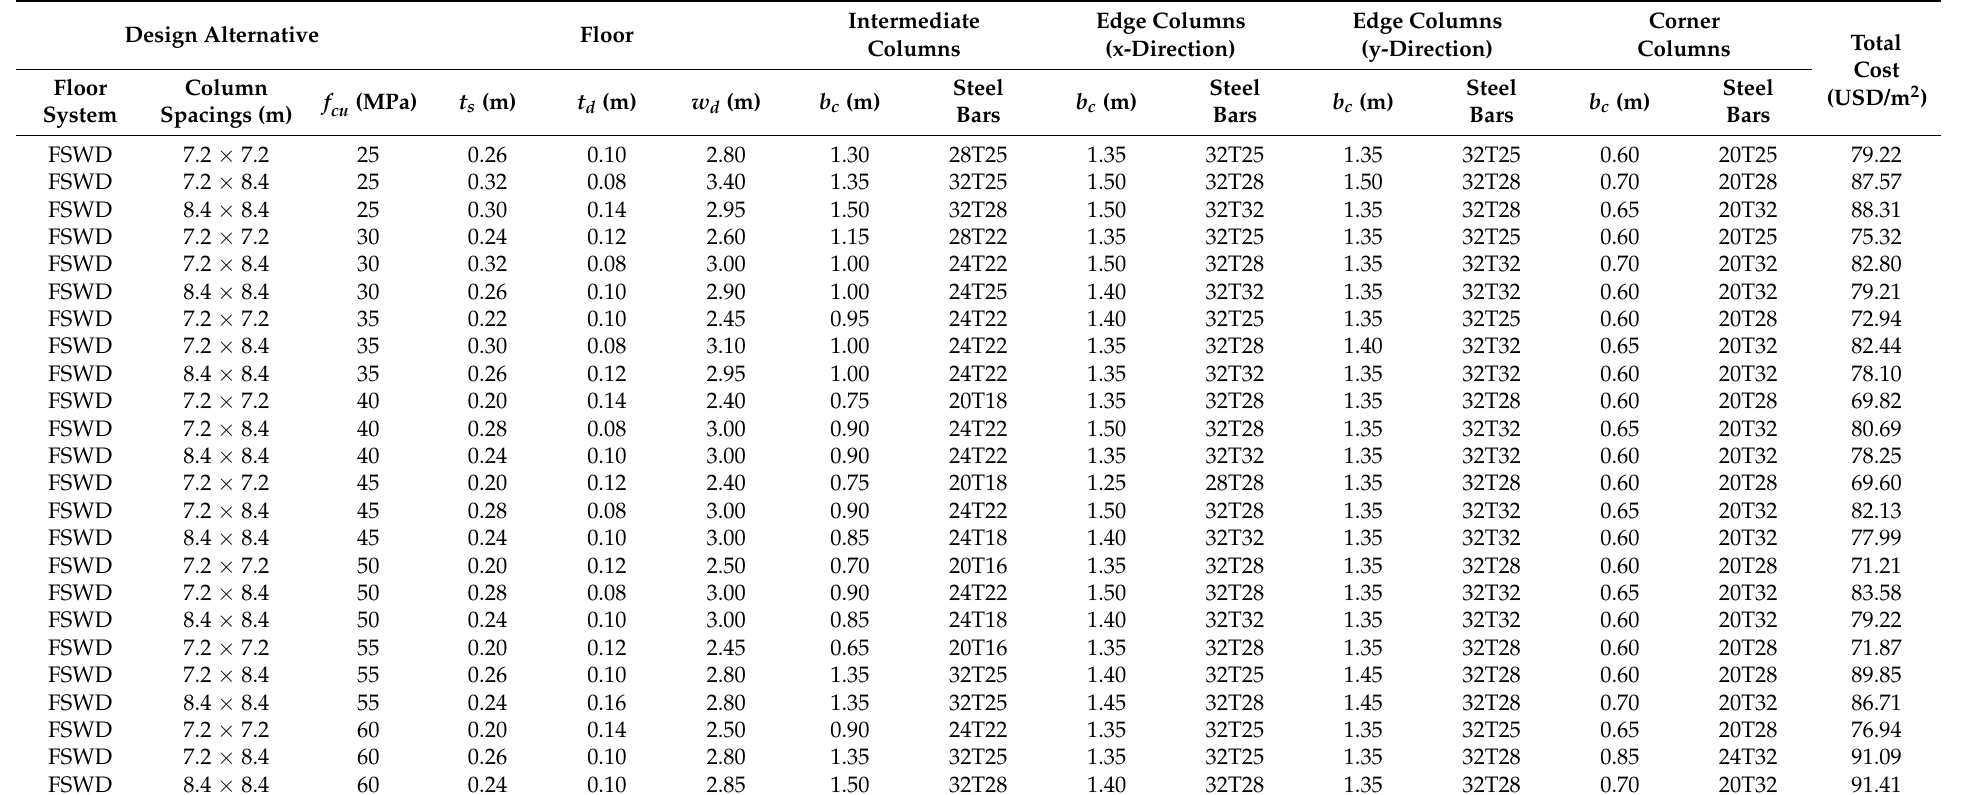
Table A1. Summary of optimal design parameters for all design